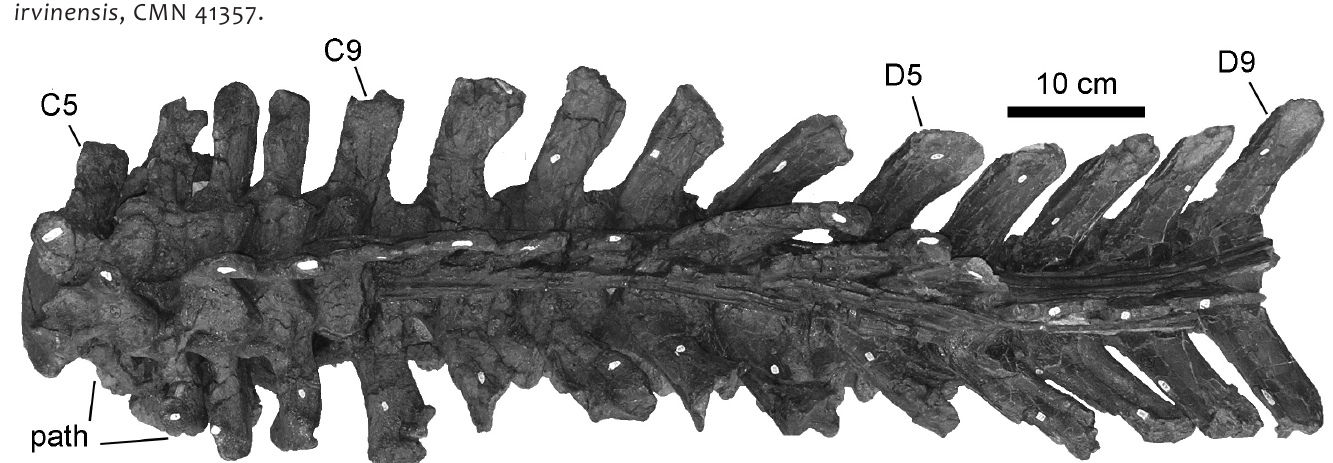
Figure 8. Cervical vertebra five to dorsal vertebra 9, in dorsal view. Vagaceratops irvinensis , CMN